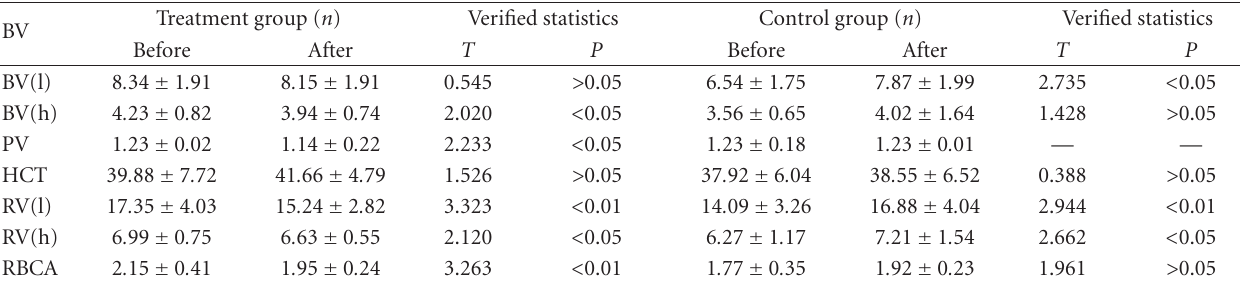
Table 2: Blood viscosity index (mean ± S.E.M).